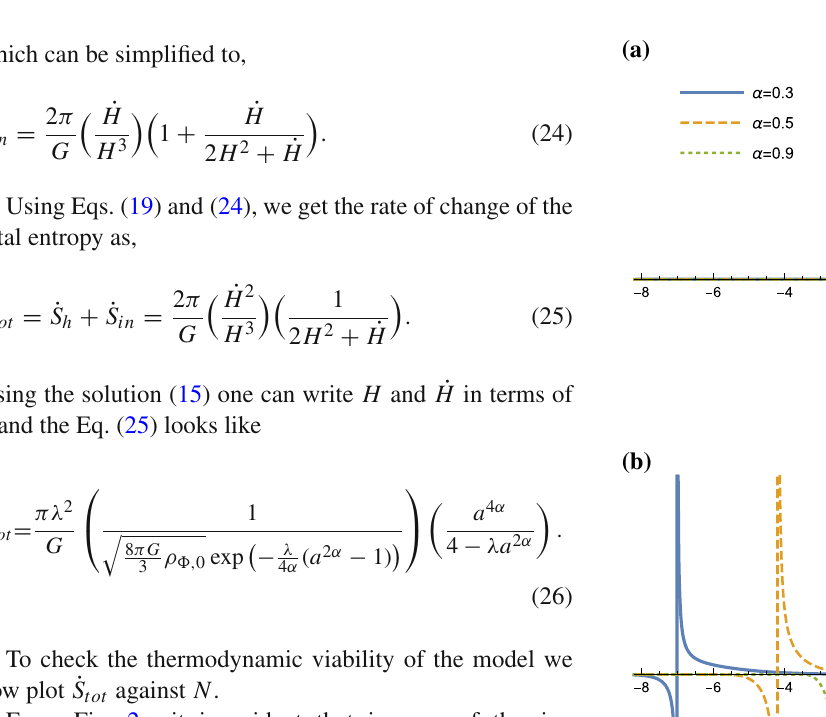
Fig. 1 w (cid:3) is plotted as a function of N . a For positive values of α , EoS increases from − 1, i.e., it exhibits a thawing behavior. b For negative values of α , EoS > − 1 decreases to more negative value, i.e., it exhibits a freezing behavior